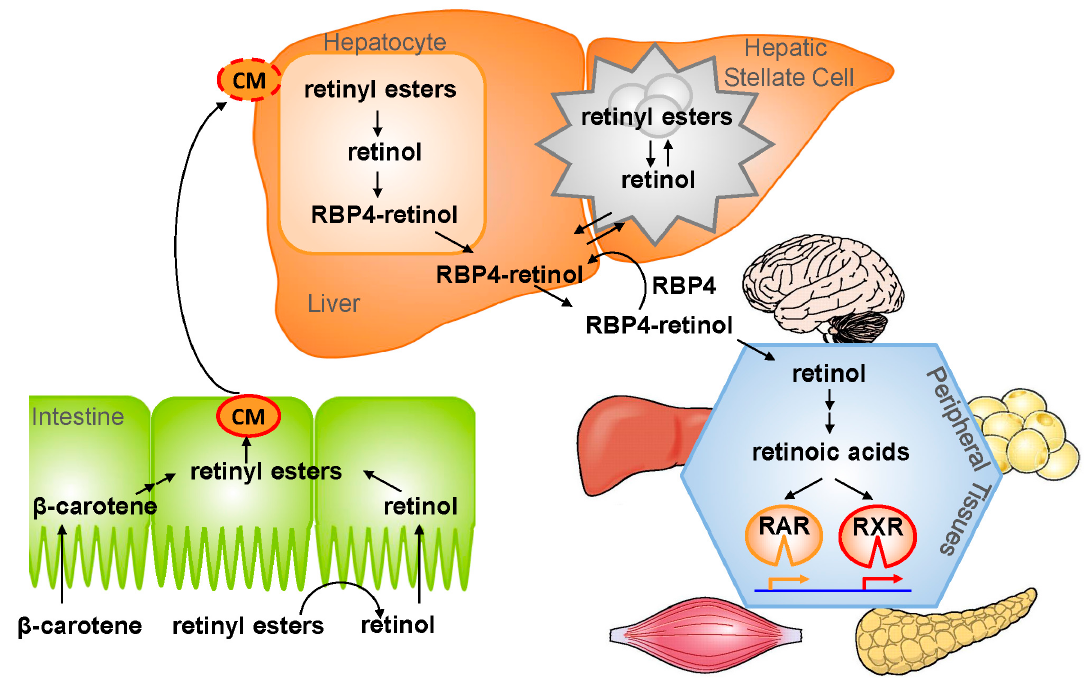
Figure 1. Schematic representation of intestinal vitamin A absorption, transport to, and storage in the liver and redistribution to peripheral tissues (see main text for details). Carotenes (from plants) and retinyl esters (from animals) are the main dietary sources of vitamin A (lower left corner). They are absorbed in the proximal small intestine and transported as retinyl esters in chylomicrons (CM) to the liver. Chylomicron remnants are taken up by hepatocytes and retinyl esters are hydrolyzed to form retinol. Hepatocytes produce retinol binding protein 4 (RBP4) and retinol binding to RBP4 stimulates the secretion of retinol-carrying holo-RBP4 to the circulation. Retinol is then either transported to hepatic stellate cells for storage as retinyl esters or transported to peripheral tissues where it is converted to retinoic acids that activate the transcription factors retinoic acid receptor (RAR) or retinoid X receptor (RXR). In times of inadequate vitamin A intake, retinol is released from the HSC stores to maintain stable levels of circulating retinol (~2 µ M in human).